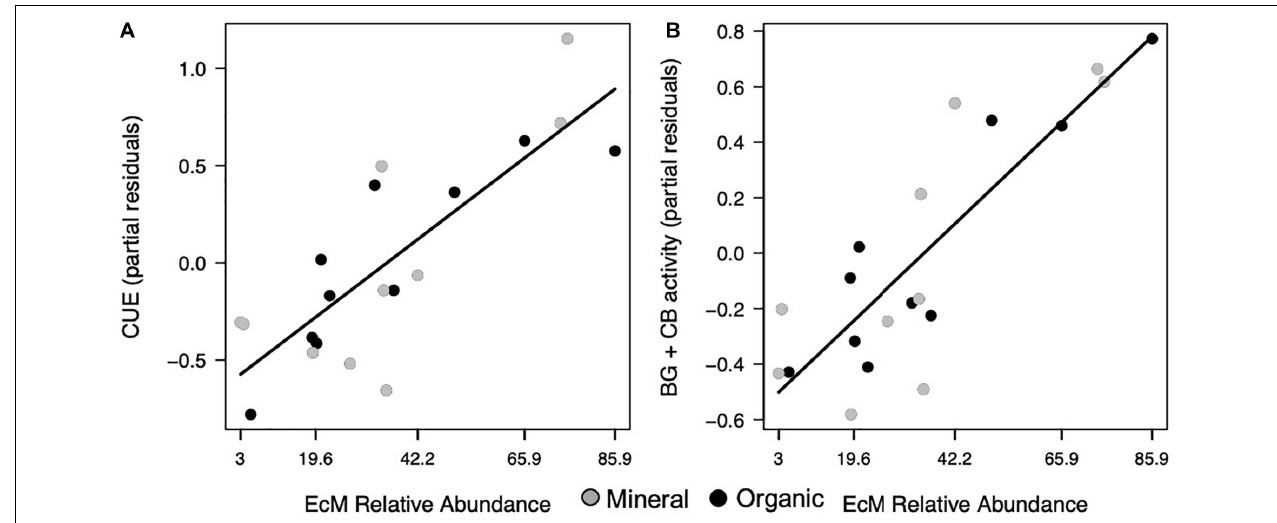
FIGURE 3 | Microbial functions responded to EcM relative abundance, where (A) CUE and (B) combined activities of BG and CB increased in both horizons. Points represent the partial residuals of each response variable plotted against EcM relative abundance. Black solid lines represent linear relationships with no horizon interaction ( p < 0.05).